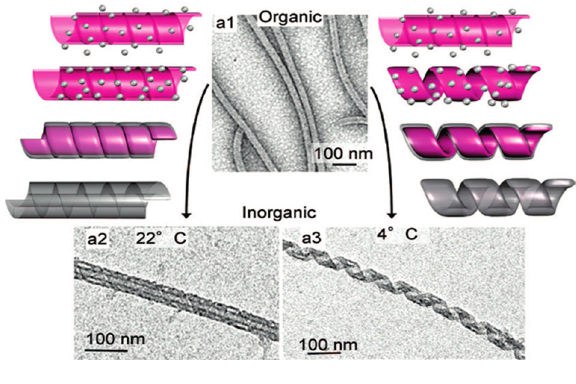
Figure 4. TEM photos showing the effects of the transcription temperature on ( a1 ) gemini surfactants organogels having tubular morphology; ( a2 ) silica nanotubes at 22 °C; and ( a3 ) silica nanohelices at 4 °C. Copyright 2008 American Chemical Society. Reprinted with permission from reference